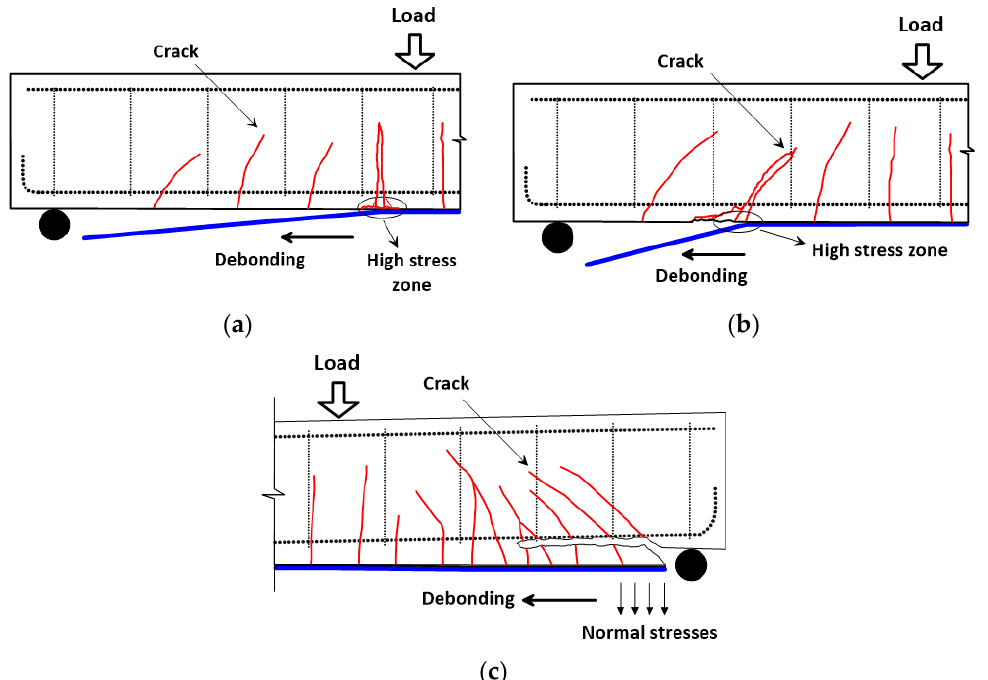
Figure 1. Common types of debonding failures in FRP-strengthened beams: ( a ) interfacial debonding induced by intermediate flexural cracks; ( b ) interfacial debonding induced by intermediate flexural-shear cracks; ( c ) concrete cover separation.